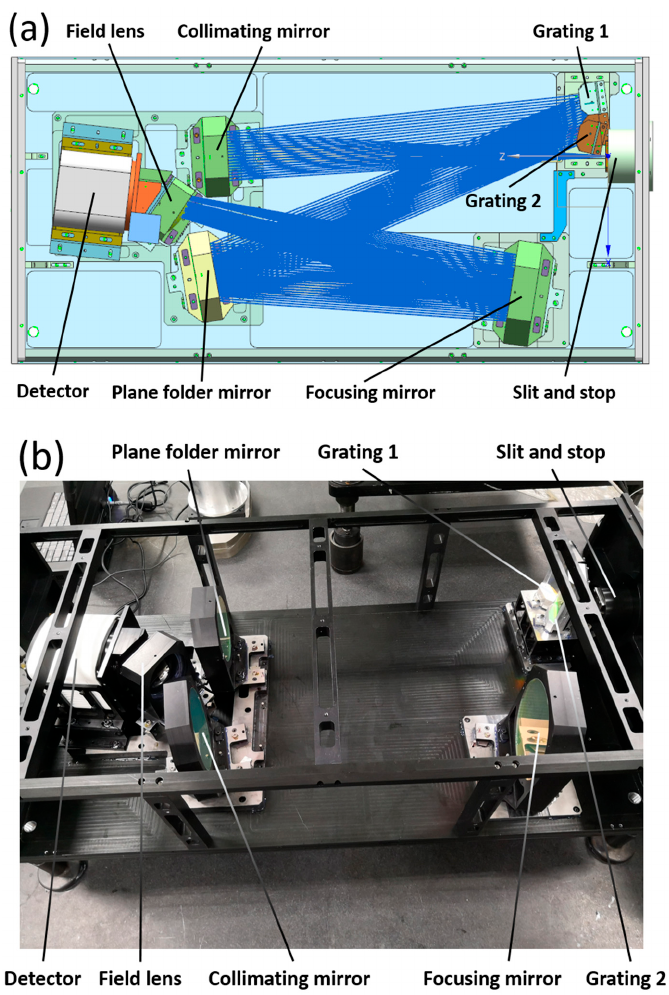
Figure 9. ( a ) The mechanical structure of the double ‐ grating spectrometer in the design stage; ( b ) The actual internal structure of the double ‐ grating spectrometer in the setup stage.